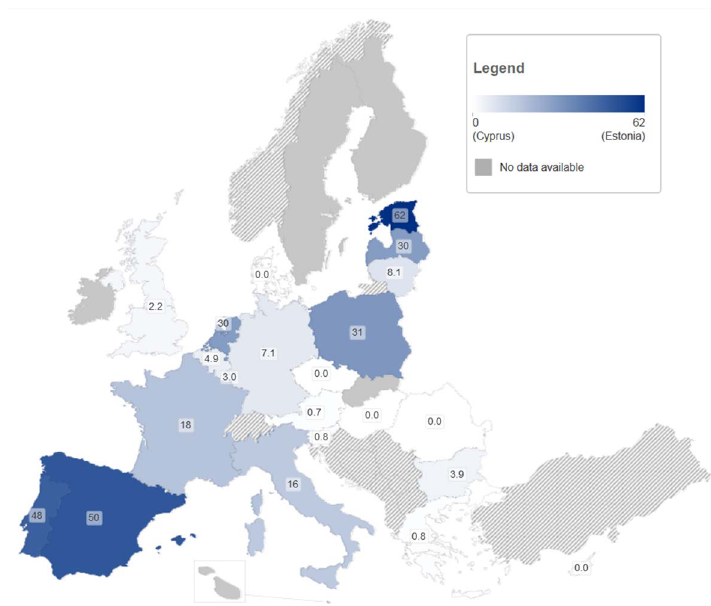
Figure 6. Proportion (%) of HCV positive PWID (antibody or RNA) undiagnosed.